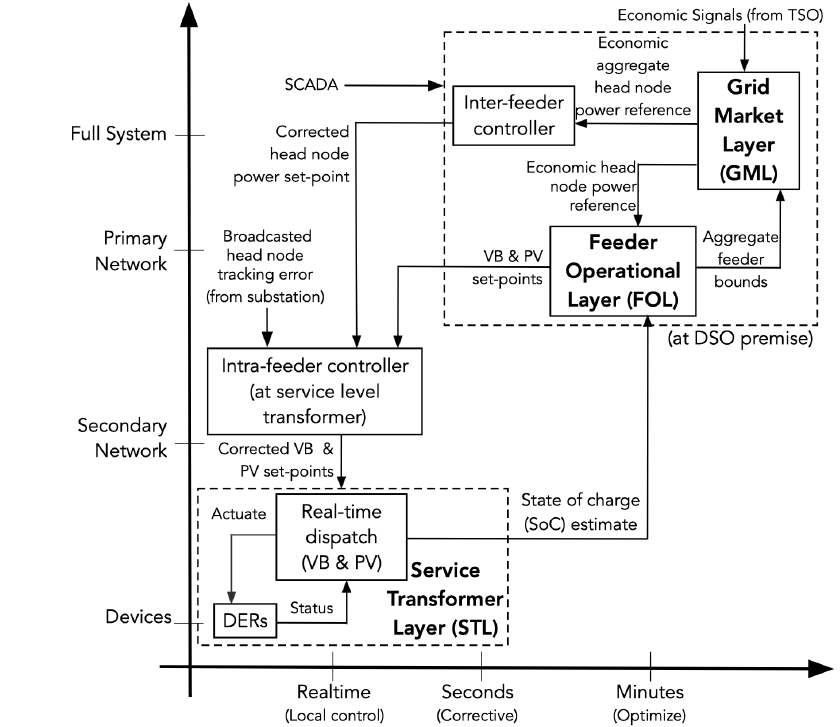
Figure 1. Hierarchical distributed energy resources (DER) control scheme along qualitative spatio-temporal